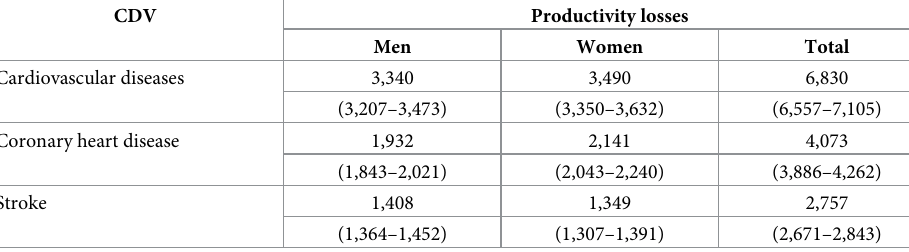
Table 6. Estimated costs (thousand USD $) of productivity losses by CVD type and gender for CCSS due to exces- sive salt intake in Costa Rica,